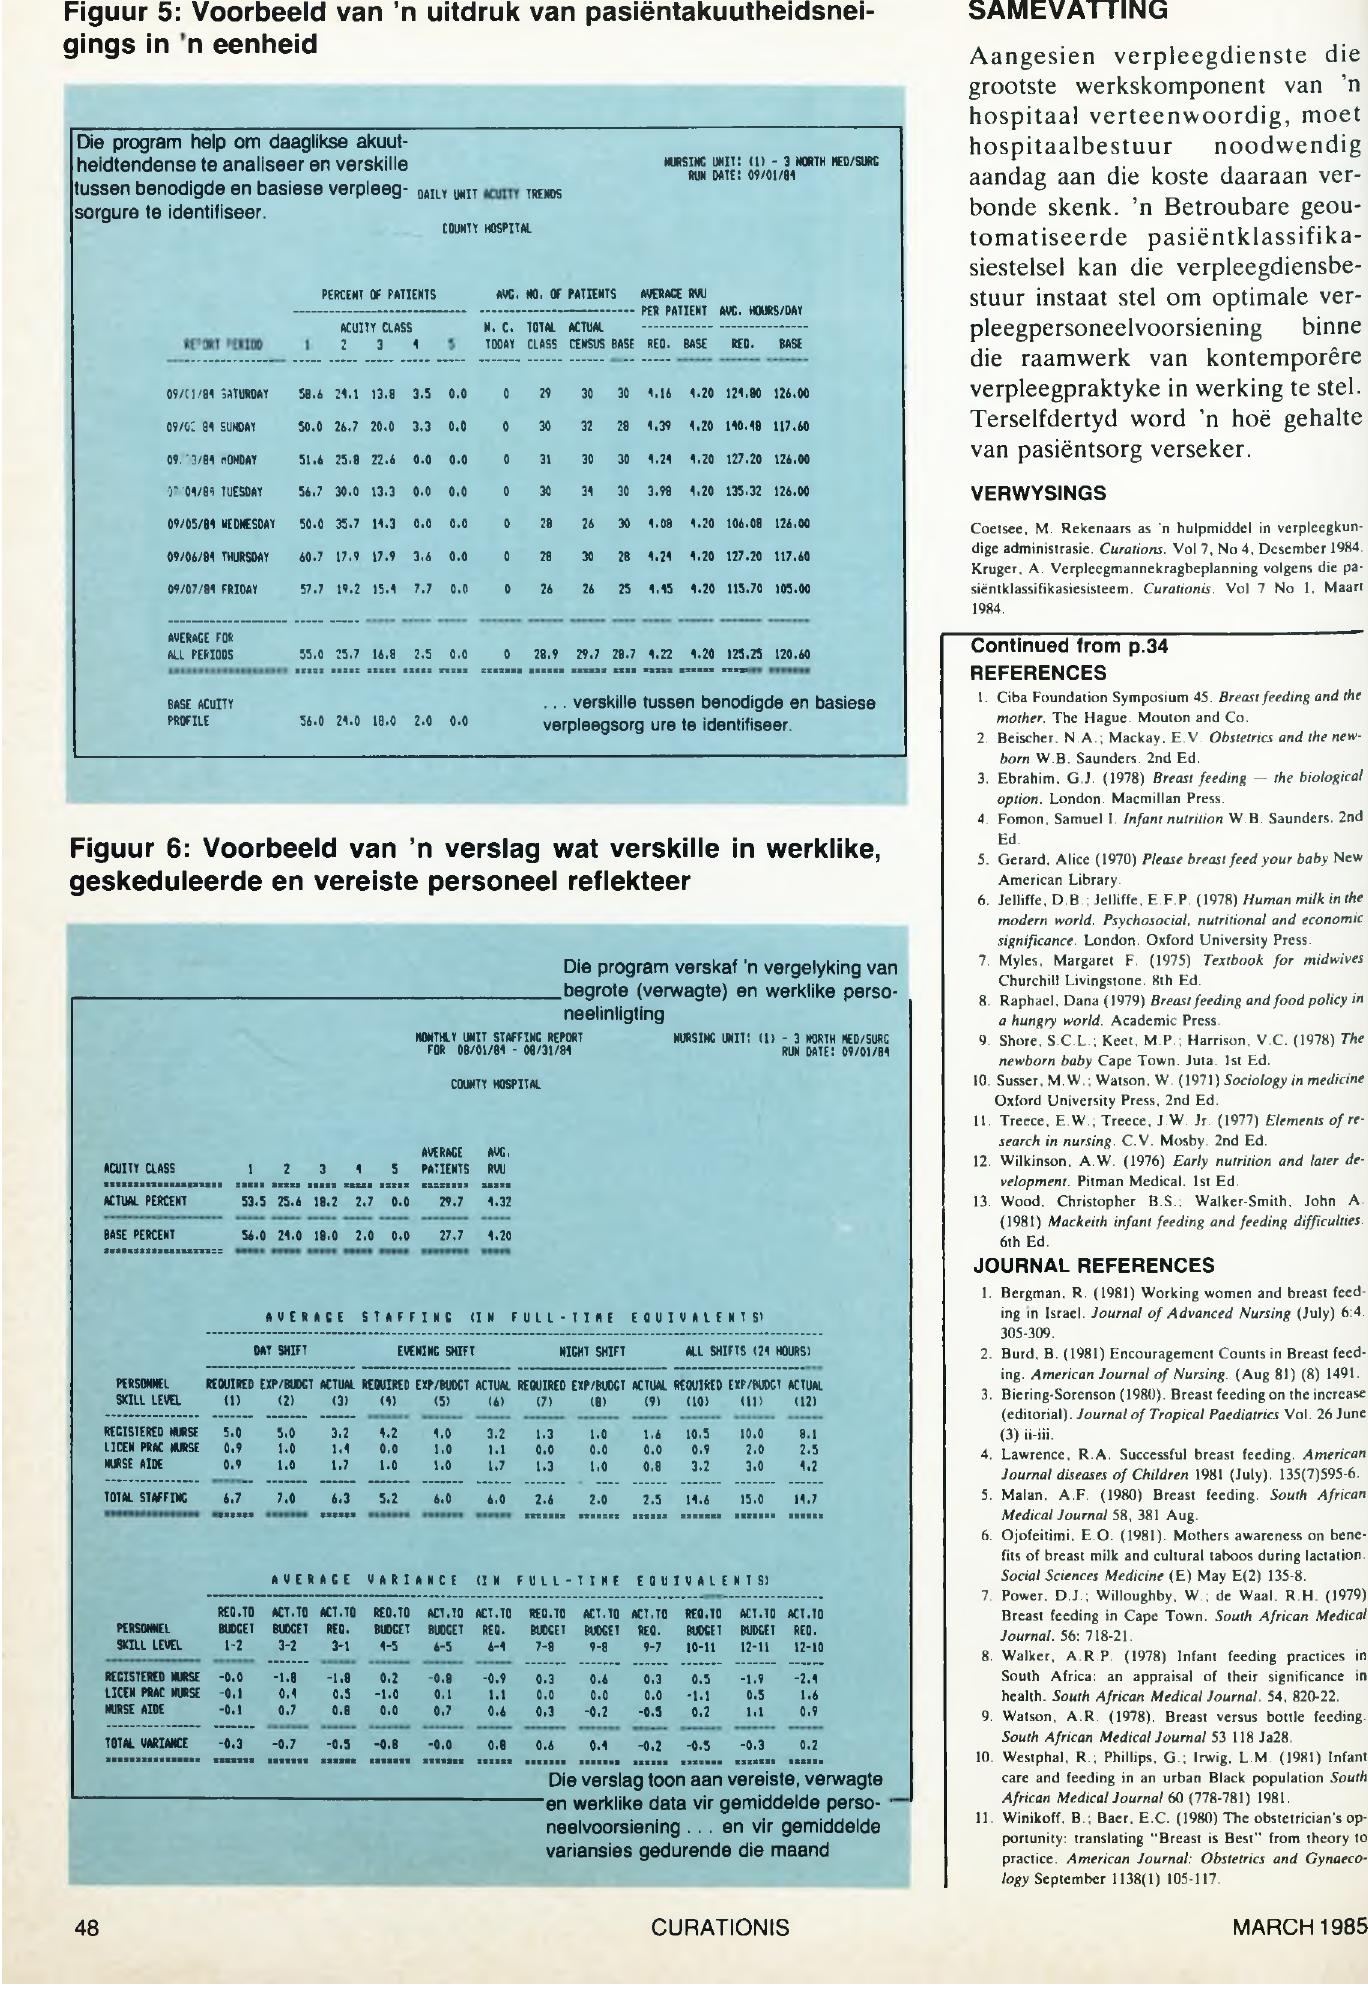
Figuur 5: Voorbeeld van ’n uitdruk van pasiëntakuutheidsnei-